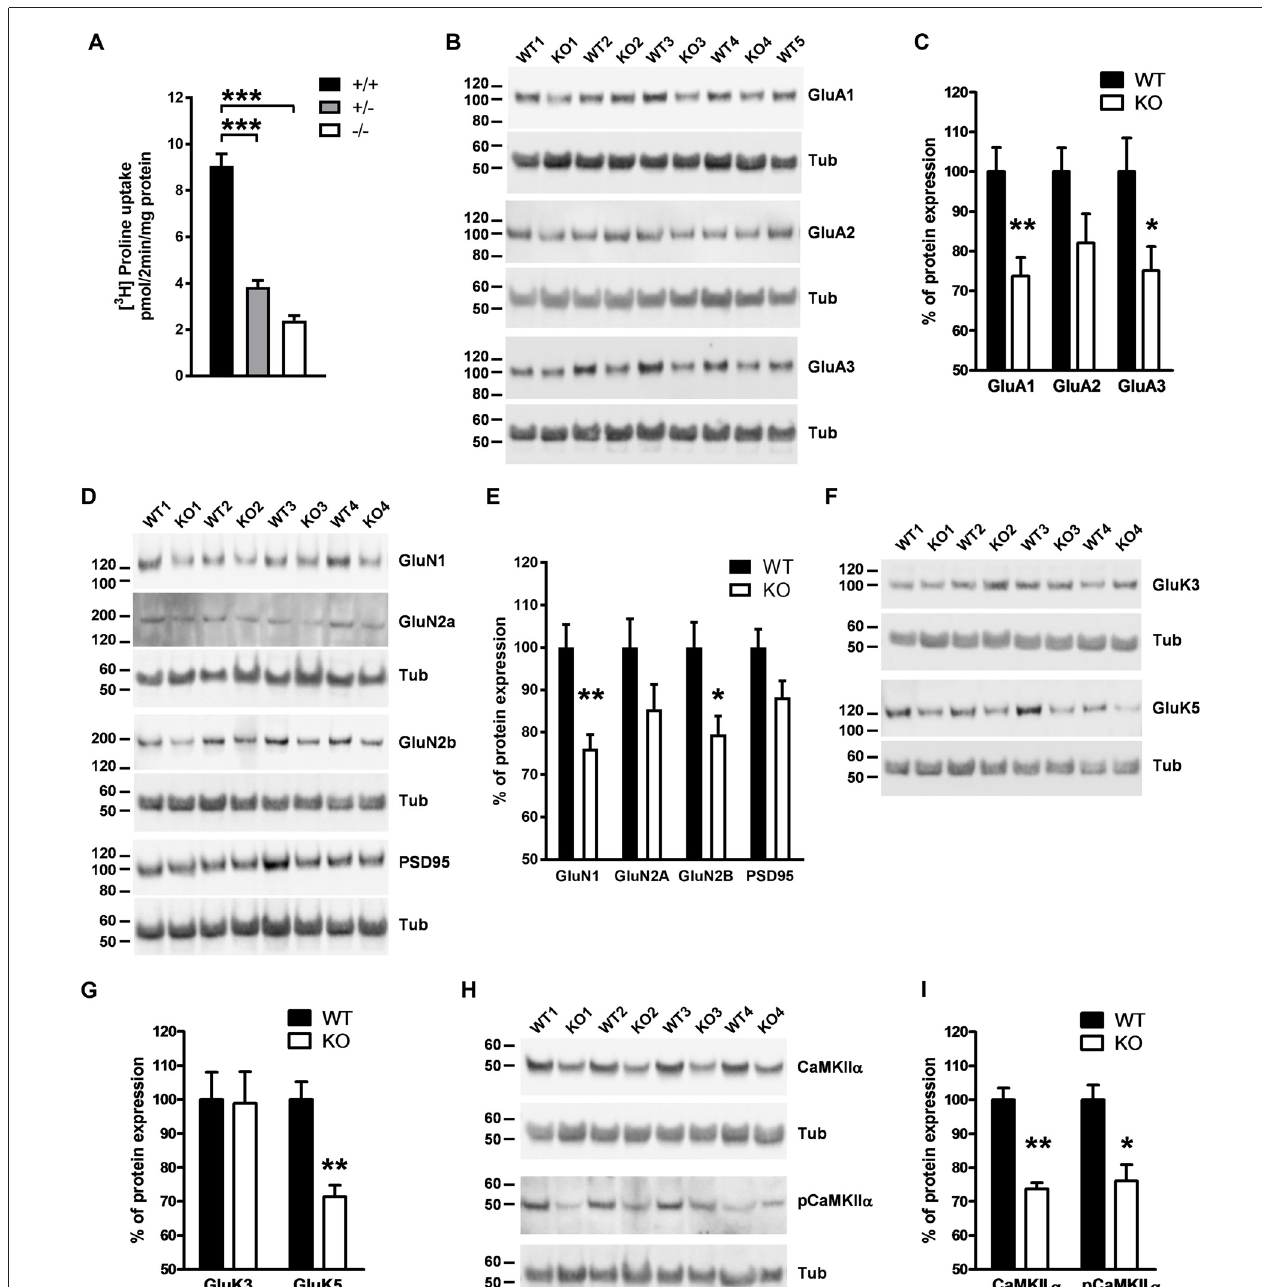
FIGURE 7 | Analysis of components of glutamatergic synapses in thalamus of PROT deficient mice. (A) L-proline uptake is reduced in PROT − / − thalamus; membranes were prepared from thalamus of WT (+/+), heterozygous (+/ − ), and homozygous ( − / − ) KO mice, and assayed for L-proline transport activity for 2 min. (B–I) Crude synaptosomes (P2) prepared from the thalamus of WT and PROT deficient (KO) animals ( n = 11 mice for each genotype) were analyzed by Western blotting; illustrative Western blots and quantitative analyses of immunoreactive band abundance corrected by β -tubulin for α -amino-3-hydroxy-5-methyl-4-isoxazolepropionic acid (AMPA) receptor subunits (B,C) , N-methyl-D-aspartate (NMDA) receptor subunits and PSD95 (D,E) , kainate receptor subunits (F,G) and calcium/calmodulin-dependent protein kinase II alpha (CaMKII α ) (H,I) are depicted. Data are presented as means ± SEM. (A) One-way ANOVA with Bonferroni’s post hoc test; (C,E,G,I) two-tailed Student’s t test; ∗ p < 0.05; ∗∗ p < 0.01; ∗∗∗ p < 0.001.